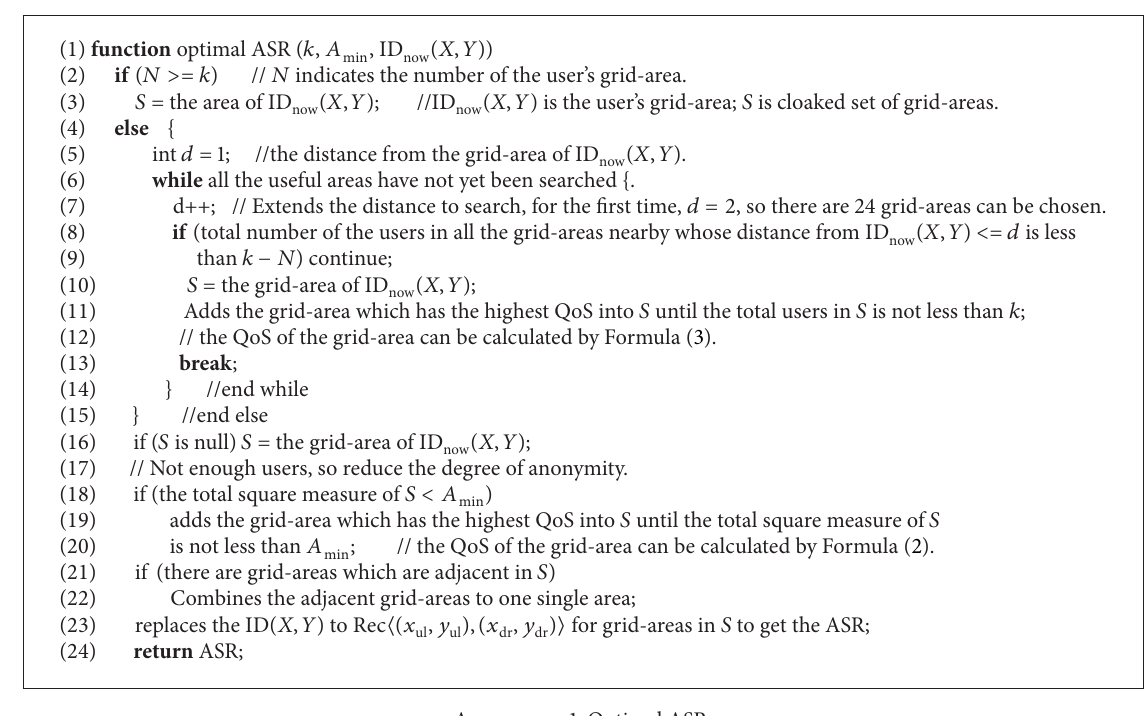
Algorithm 1: Optimal ASR.